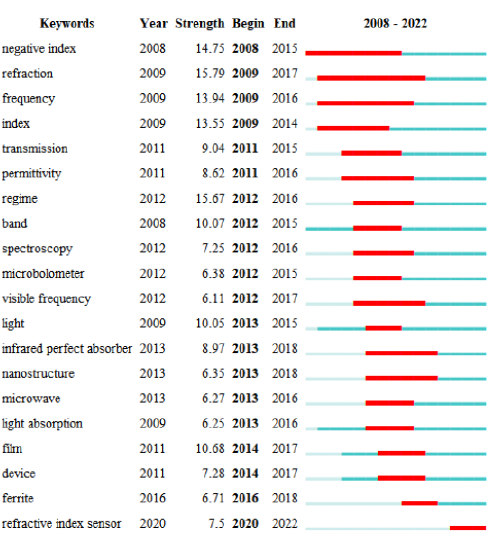
Figure 5. Keywords co-occurrence network of metamaterial absorber. Table 4. The top ten keywords in the research area of metamaterial absorbers.